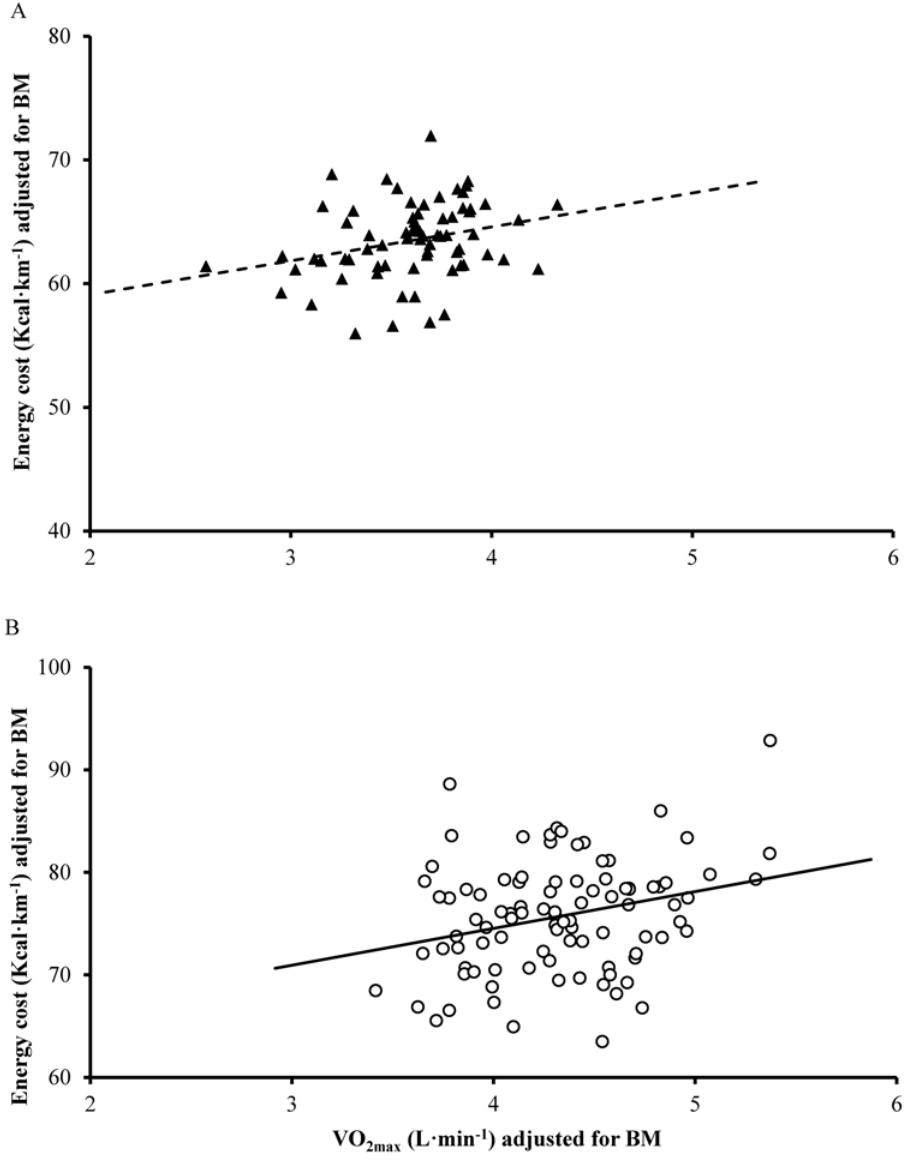
Fig 1. Scatter plot of energy cost (Kcal (cid:1) km -1 ) adjusted for body mass (BM) vs V ̇ O 2max (L (cid:1) min -1 ) adjusted for BM for both females (A; n = 70; r = 0.25; P = 0.036) and males (B; n = 98; r = 0.26; P = 0.009) within the cross-sectional